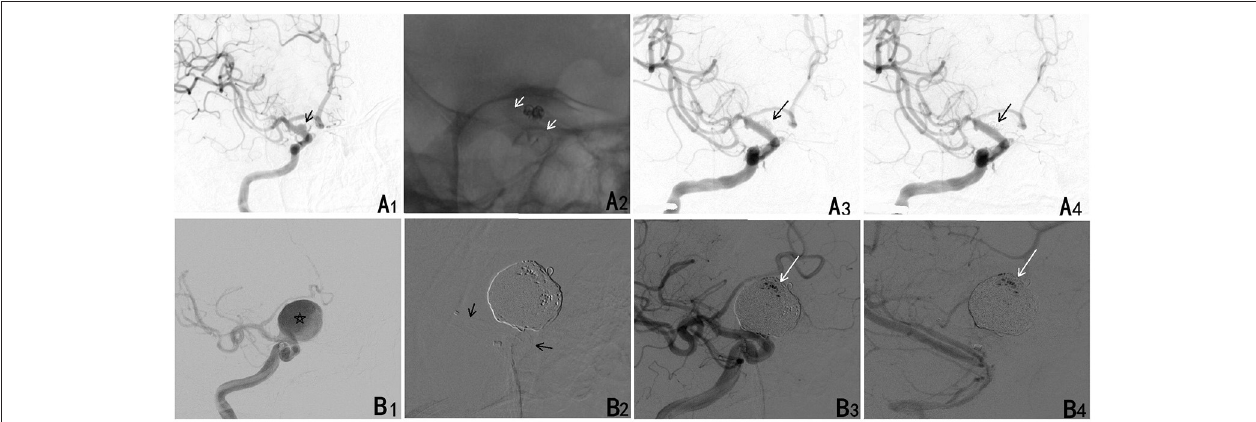
FIGURE 1 | (A) A ruptured blood blister aneurysm treated with a PED. (A1) A ruptured blood blister aneurysm of the internal carotid artery (ICA) (black arrow). (A2) The aneurysm was treated with loosing packed coiling and a PED (white arrow). (A3) The aneurysm continued to fill completely in the arterial phase. (A4) The contrast cleared within the arterial phase. (B) A larger ruptured aneurysm treated with a PED. (B1) A ruptured saccular aneurysm of the ICA (star). (B2) The aneurysm was treated with densely packed coiling and a PED (black arrow). (B3) The aneurysm continued to fill incompletely in the arterial phase. (B4) Contrast stasis persisted through the venous